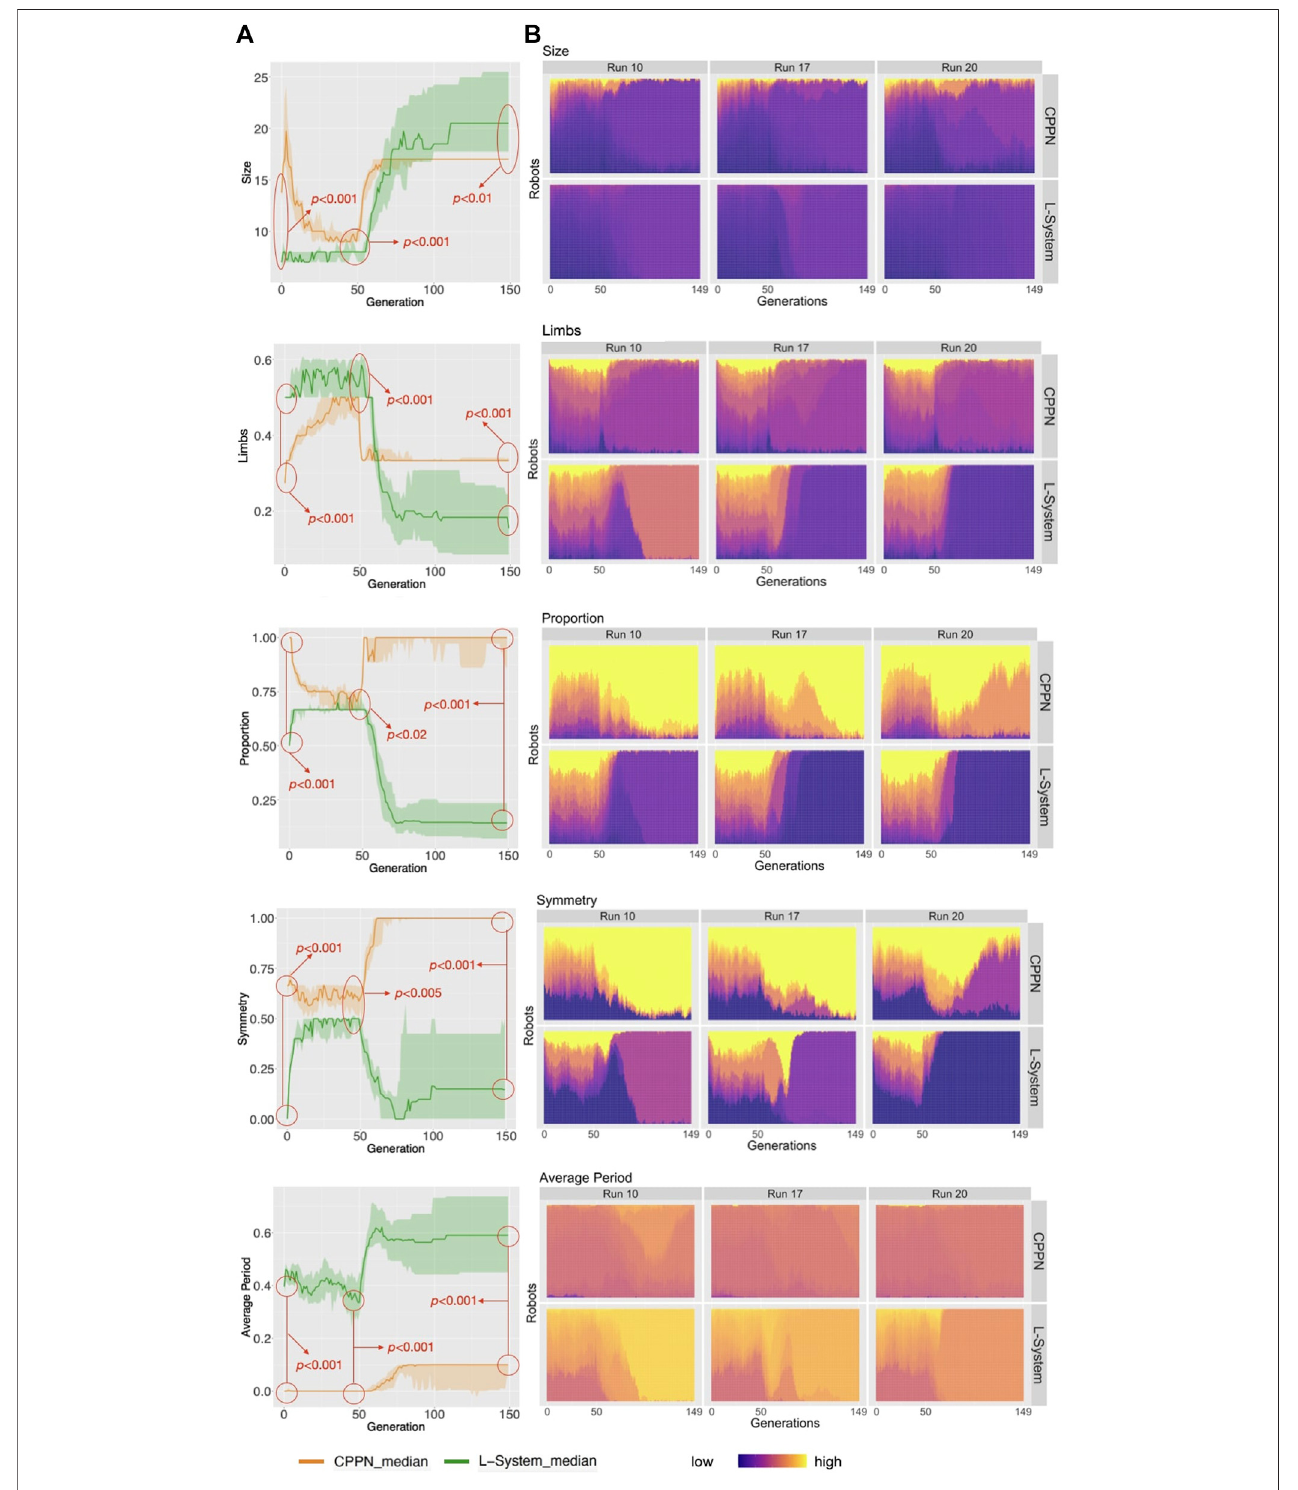
FIGURE 5 | (A) Distribution of phenotypic traits for the populations. Aggregations and tests are the same as in Figure 4 . (B) The heat-maps display the values for the robot traits of every robot in every generation, including three example runs.